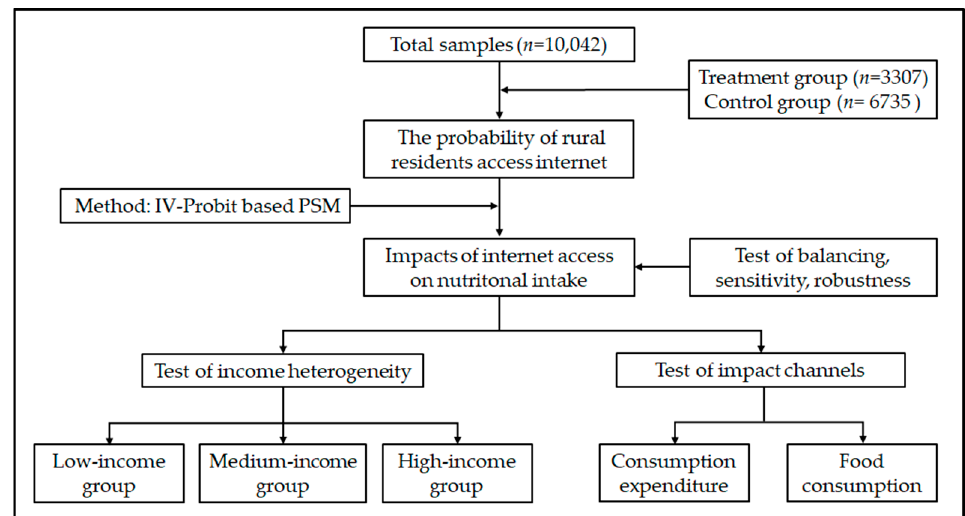
Figure 3. Flow chart of study steps.